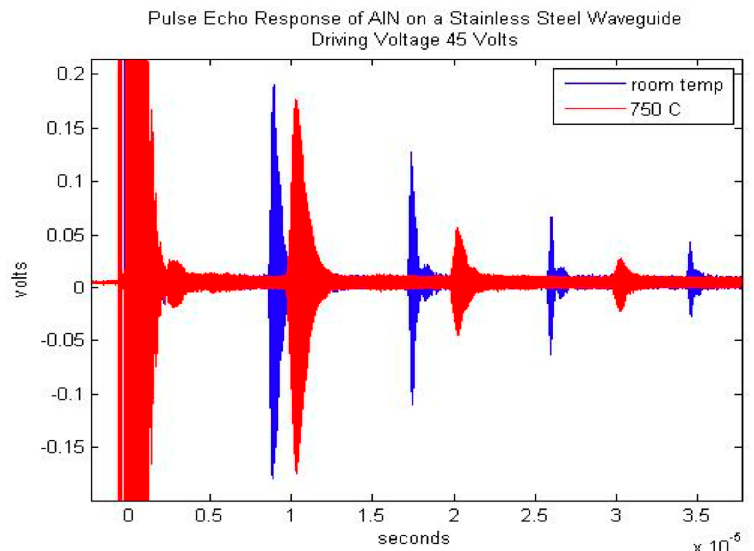
Figure 2. Pulse-echo amplitude response for a single-crystal wafer of aluminum nitride at two temperatures, 25 and 750 °C, showing only somewhat lower amplitudes at the higher temperature [2].